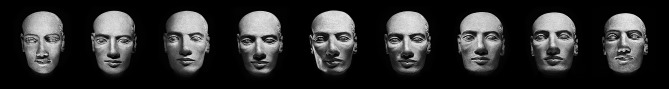
Head of Man Ca. 2289, known as
Tête Salt, painted limestone,
estimated Middle Empire 18th–20th century BC possible provenance
Karnack, High Egypt Department of Egyptian Antiquities Musée du Louvre,
Paris, France, Humanum®
Paradeigma Frieze
F9 dimension 1 to 1, 27.54 × 207 cm,
Giorgia Fiorio © 2015.